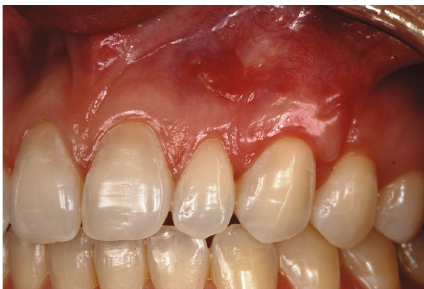
Figure 12: 30-day postoperative follow-up.